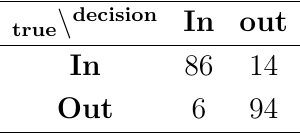
Table 6. Confusion matrix of the classes indoor and outdoor using SVM. The values denote percentages.